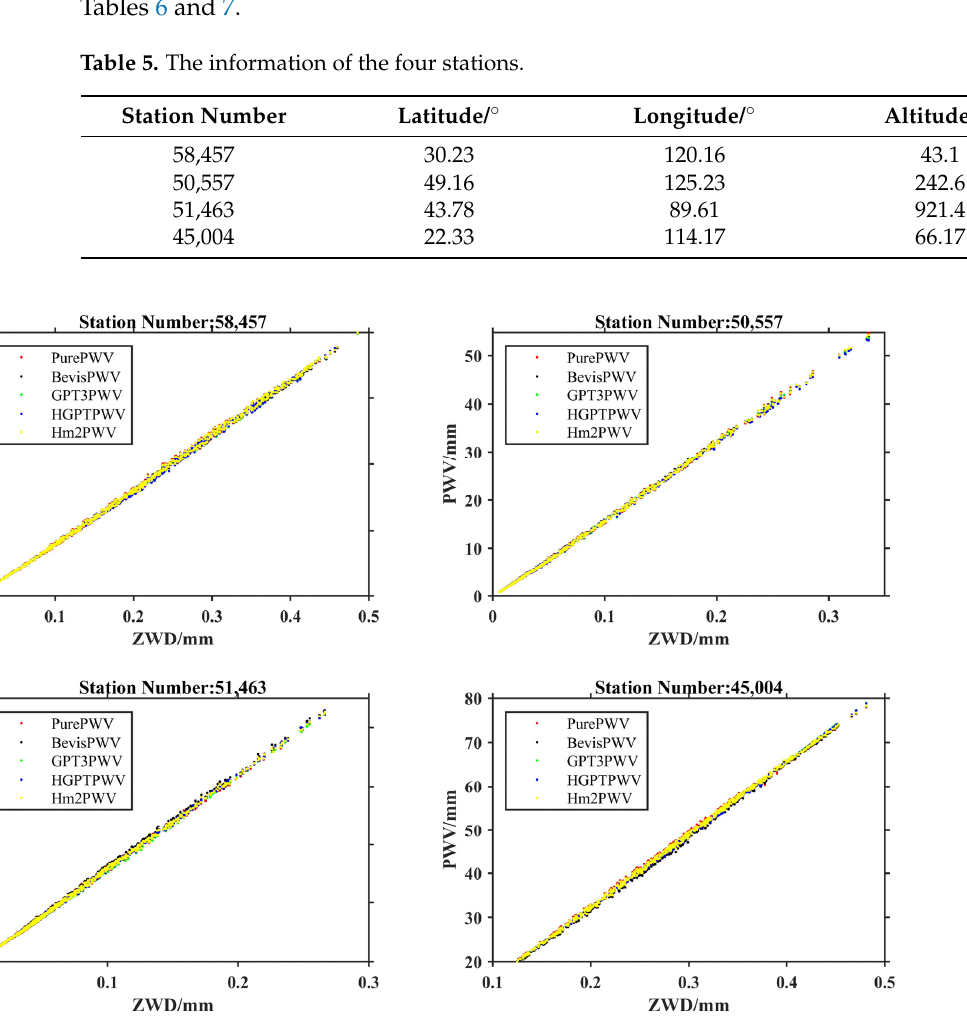
Figure 13. The PWV converted by the Bevis, GPT3, HGPT, and Hm2 models at four radiosonde stations. Table 6. The MAE of the differences between the computed and the reference PWV.